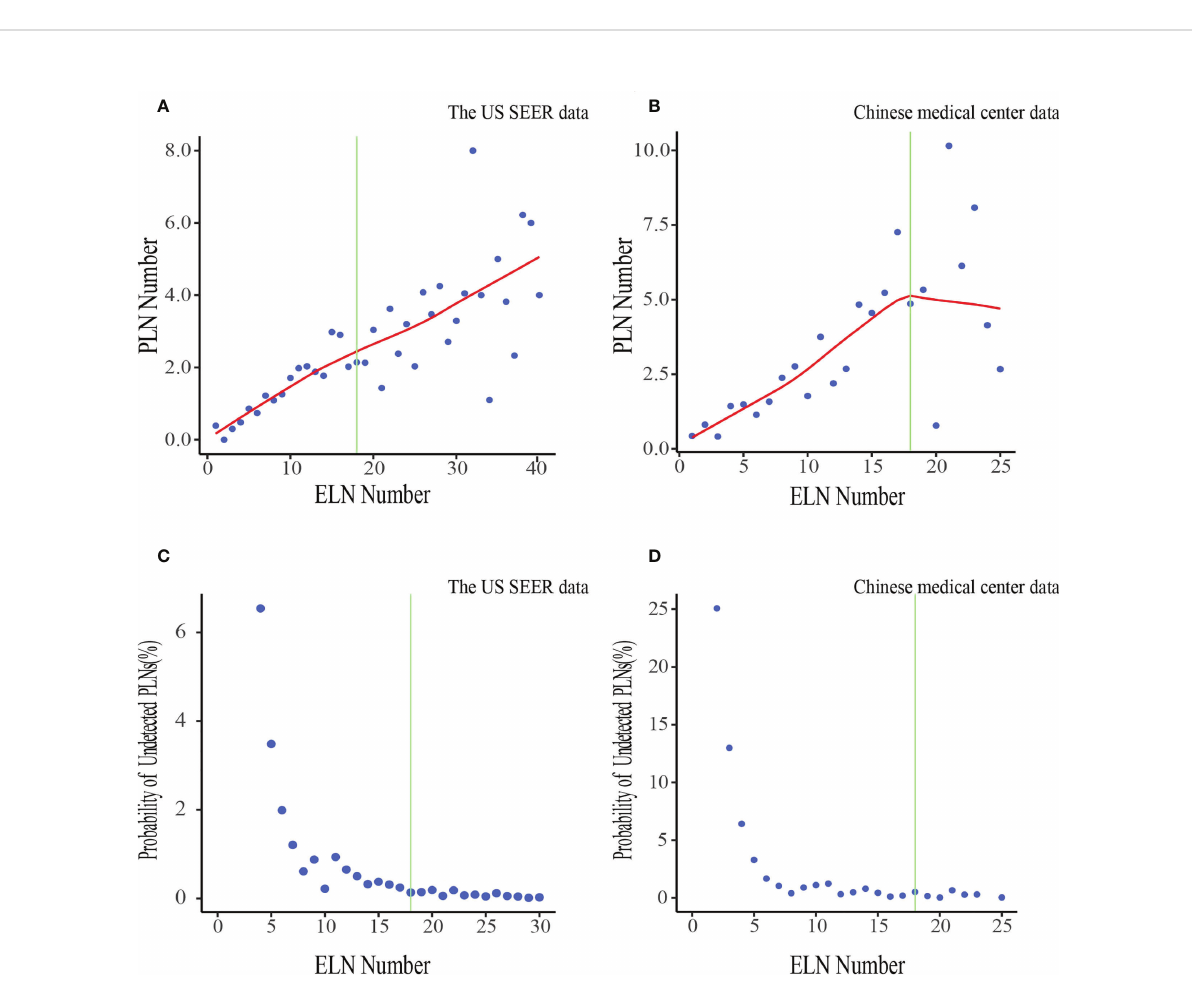
FIGURE 2 Associations of ELN number with the mean number of PLNs and the probability of undetected PLNs in the US data (A, C) and Chinese data (B, D) . LOWESS smoother- fi tted curves are shown in red. The structural breaks associated with survival in the US data(ELN =18) are shown in green. ELN, Examined lymph node; PLN, Positive lymph